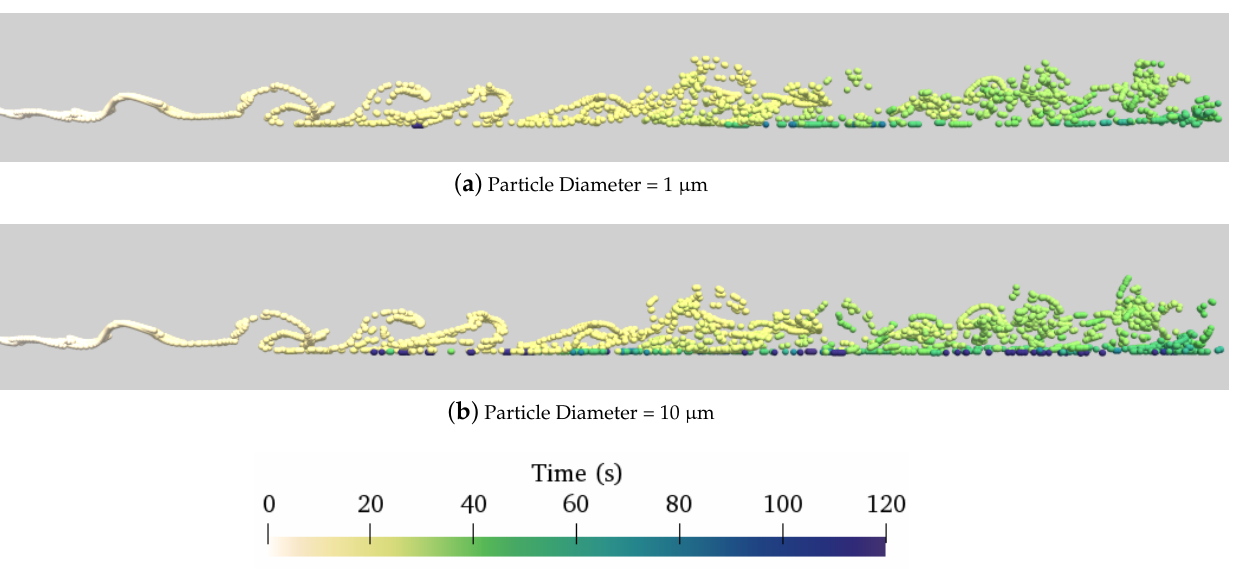
Figure 13. Spread of particles at 120 s from x = 50 m to x = 200 m (Front view with x axis along horizontal and z axis along vertical). The coloring indicates the age of the